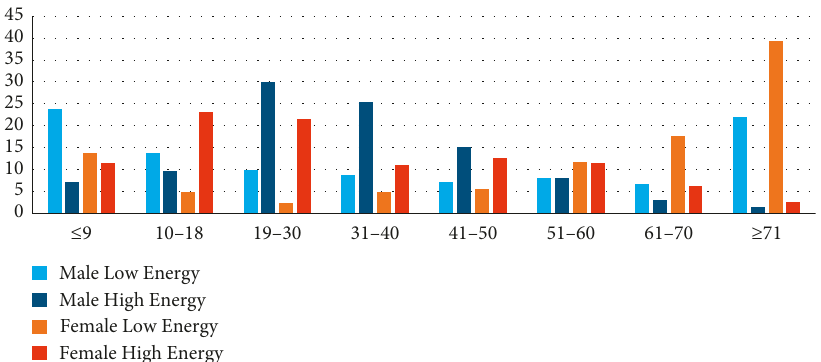
Figure 3: Fracture frequency according to injury energy across age